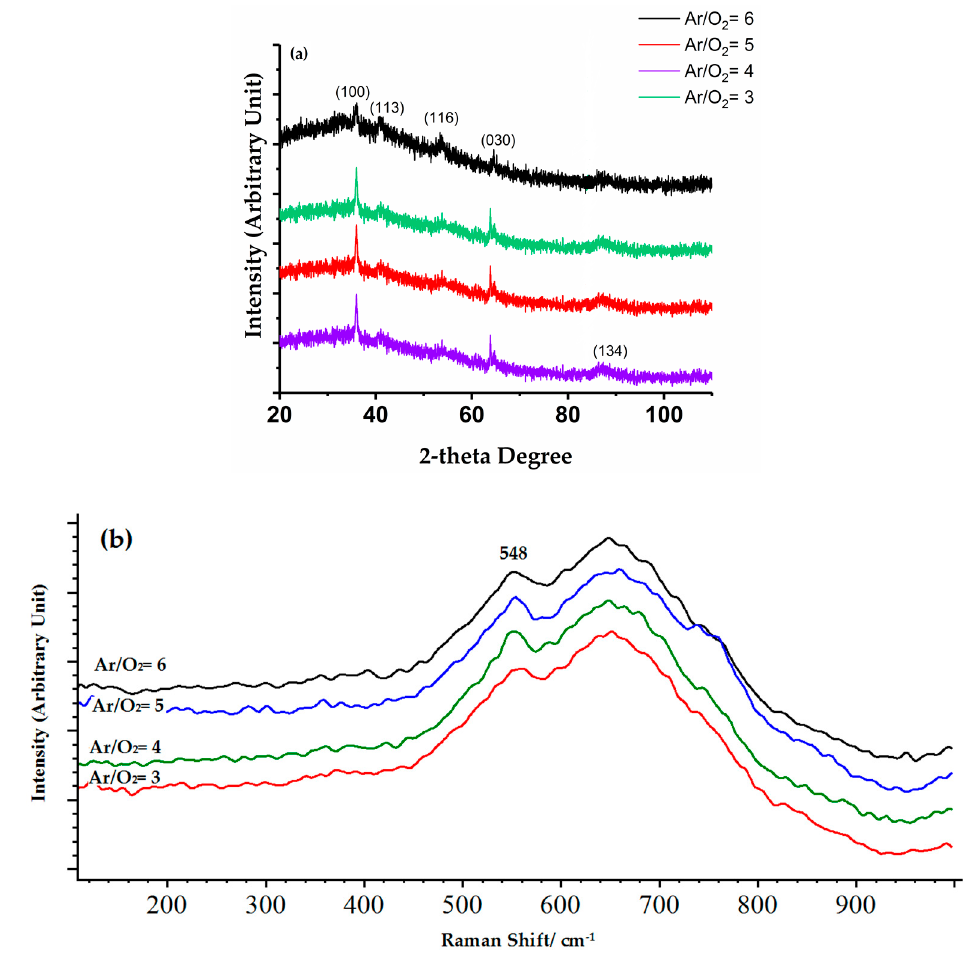
Figure 8. ( a ) XRD patterns and ( b ) Raman spectra of chromium oxide coatings deposited at different Ar/O 2 ratios.